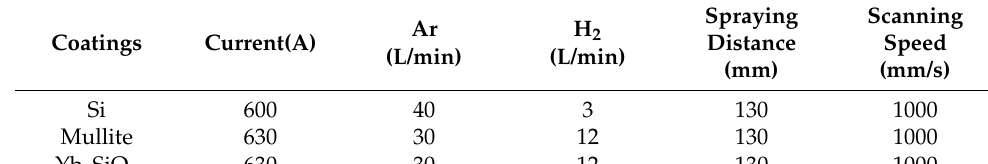
Table 1. Processing parameters of PS-PVD for each coating.